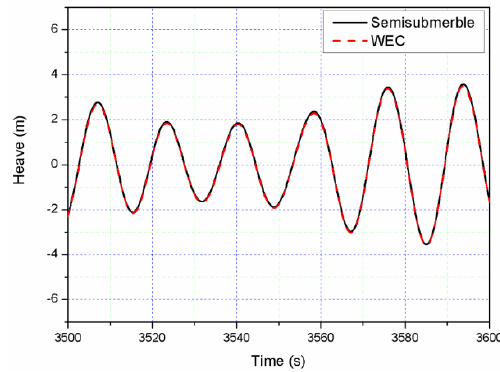
Figure 19. Relative heave of the combined structure under the locked mode.